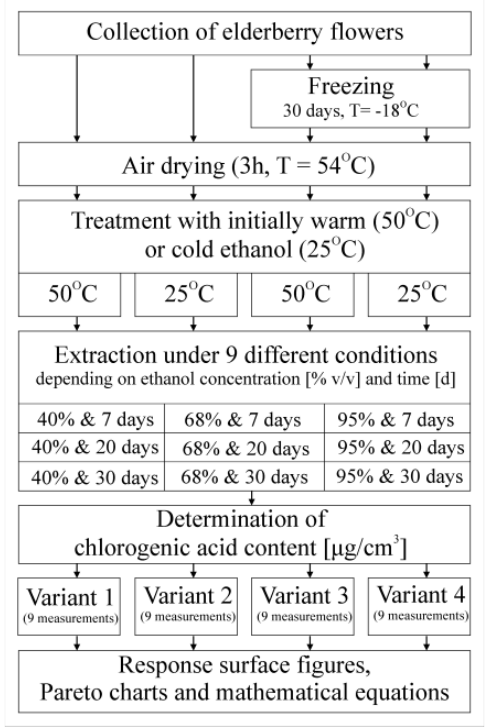
Figure 2. Experimental